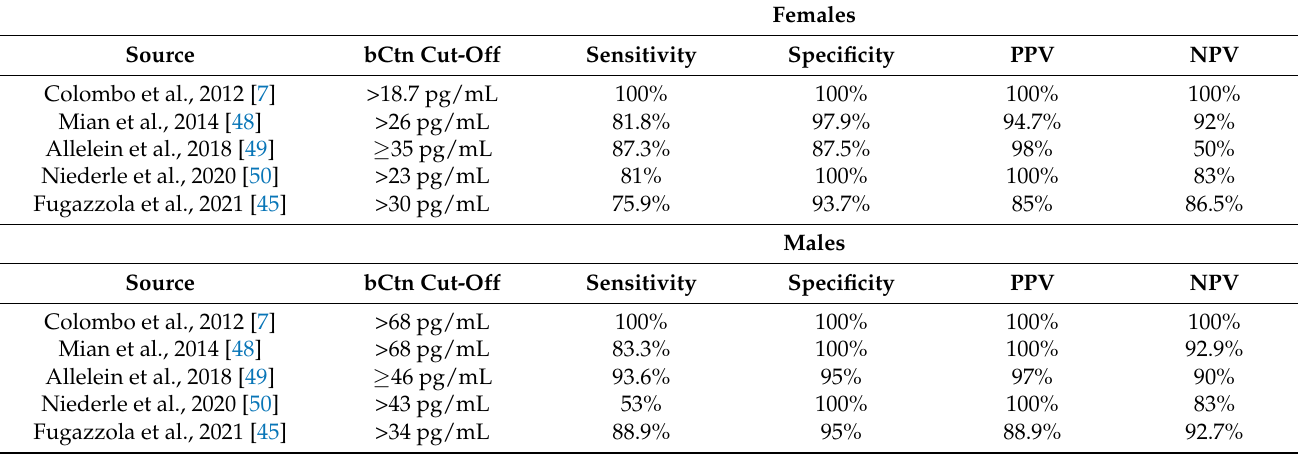
Table 2. Overview of sensitivity, specificity, positive predictive values (PPV), and negative predictive values (NPV) of sex-specific bCTn cut-off values, which were determined in various studies to differentiate between patients without C-cell pathology and CCH cases on the one hand and actual MTC- cases on the other